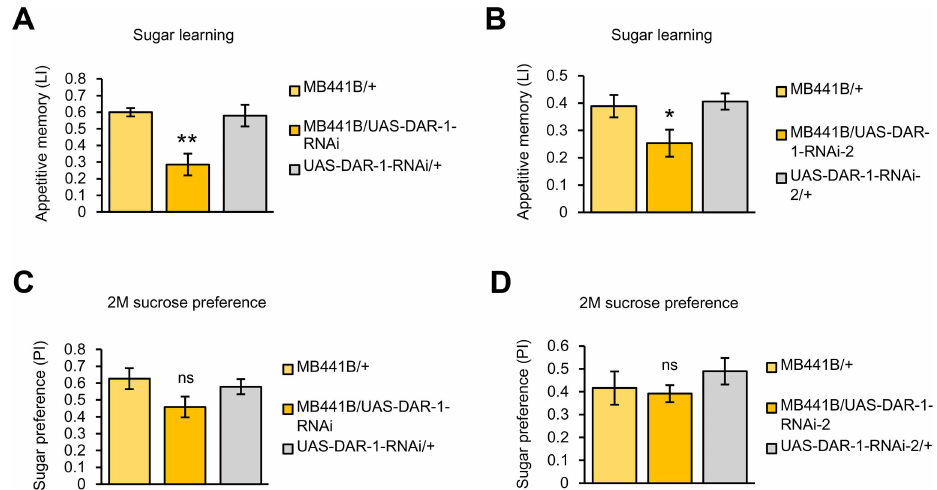
Fig 9. Requirement of DAR-1 in the PAM- γ 3 in sugar learning. (A) Down-regulation of DAR-1 expression in PAM- γ 3 by MB441B impairs immediatesugar memory. n = 12–15. (B) Knocking down DAR-1 in MB441B- GAL4 driven by second line of UAS-DAR-1-RNAi impairs sugar memory. n = 24–26. (C) Knocking-down DAR-1 in the PAM- γ 3 driven by MB441B-GAL4 did not alter innate sugar preference. n = 9. (D) Knocking down DAR-1 in the MB441B-GAL4 driven by second line of UAS-DAR-1-RNAi did not alter innate sucrose preference. n = 8. ns, not significant. * p < 0.05, ** p < 0.01.